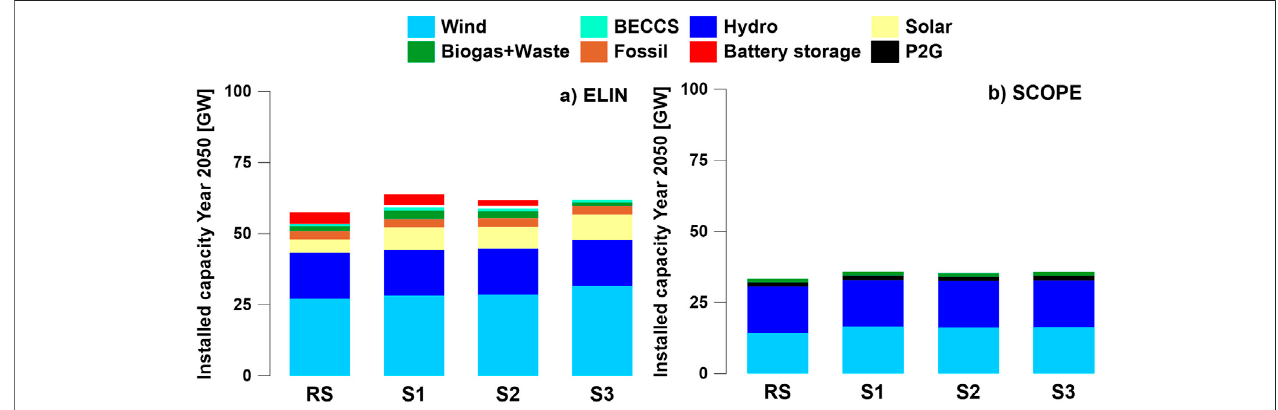
FIGURE 4 | Total capacity installed in Year 2050 in Sweden for all the scenarios in: (A) ELIN; and (B) SCOPE. BECCS, biomass with carbon capture and storage; P2G, power-to-gas.